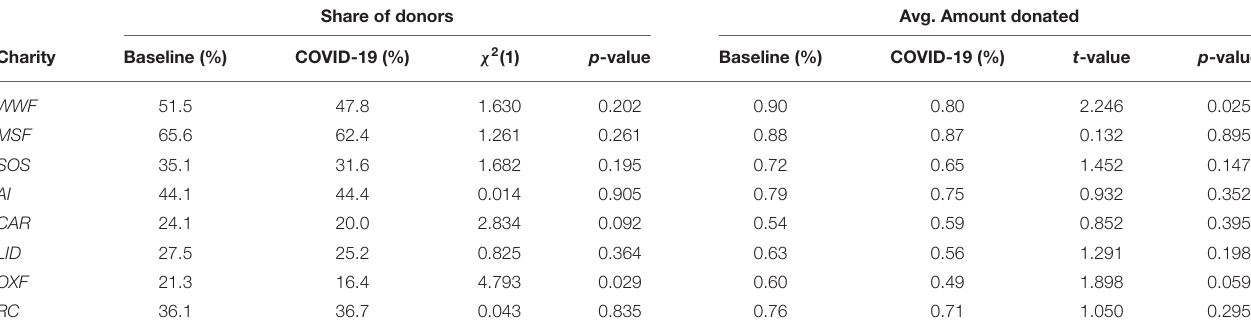
TABLE 1 | Share of participants donating any positive amount, and average amounts donated by those who donate, separated by charities and treatments. Share of donors Avg. Amount